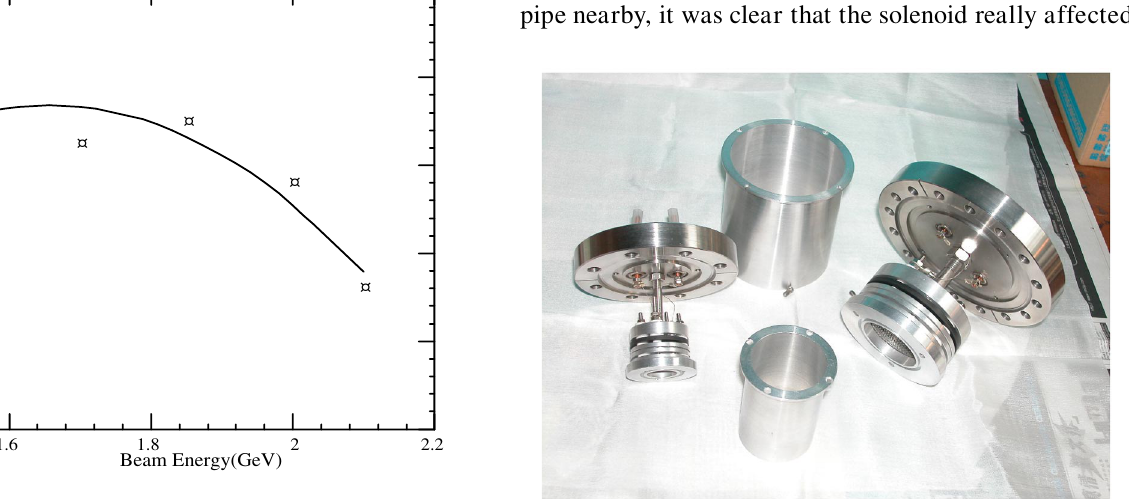
FIG. 2. The chromaticity dependence on beam energy at the threshold of the instability. FIG. 3. The detector structure for EC measurement.